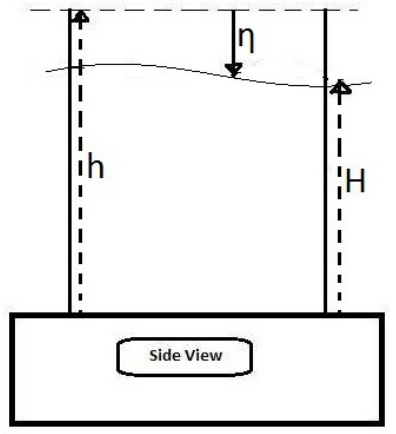
Fig. 1. ModFreeSurf2D variable definition (side view) which shows the relationship between free surface elevation η , total water depth H , and undisturbed water depth h ( Martin and Gorelick,